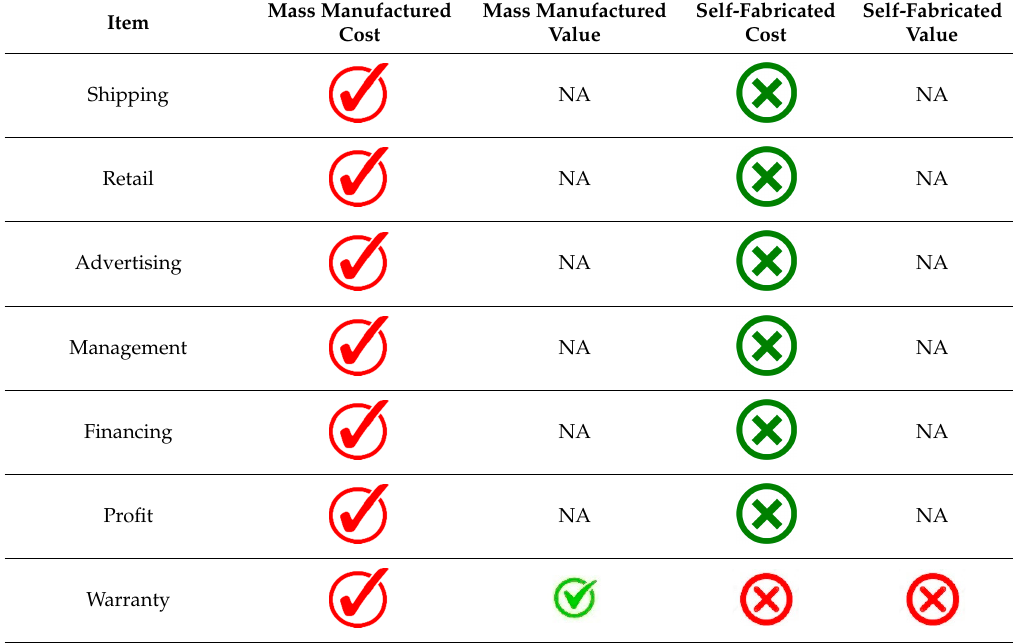
Table 5. The costs and values for a teaching aid from the teacher’s perspective (a red symbol indicates a disadvantage for the teacher/consumer while a green symbol indicates an advantage).